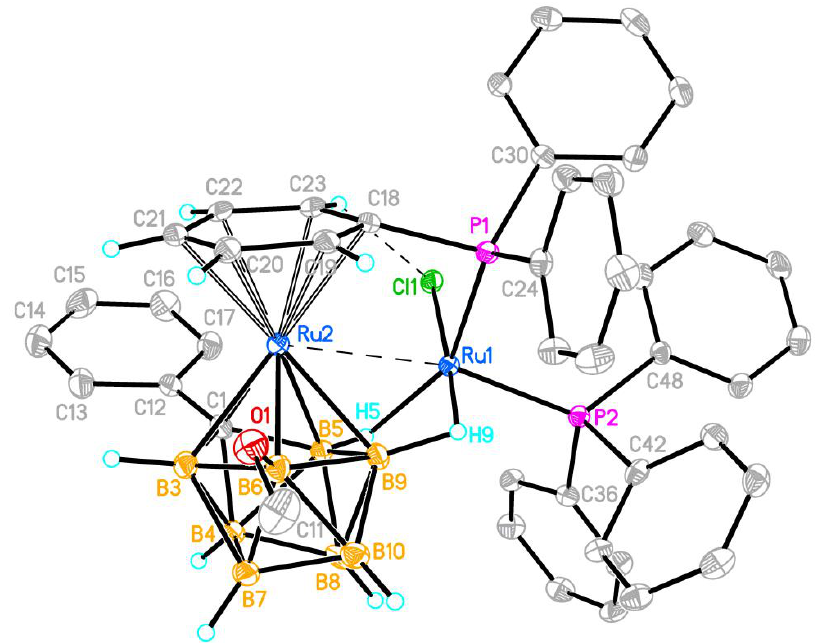
Figure 1. Molecular structure of the complex 4a (only the hydrogen atoms of the carborane and η 6 -phenyl moieties are shown; thermal ellipsoids are drawn at the 30% probability level). Selected interatomic distances (Å ) for two independent molecules A/B are: Ru(1)···Ru(2) 2.9261(6)/2.9101(6),